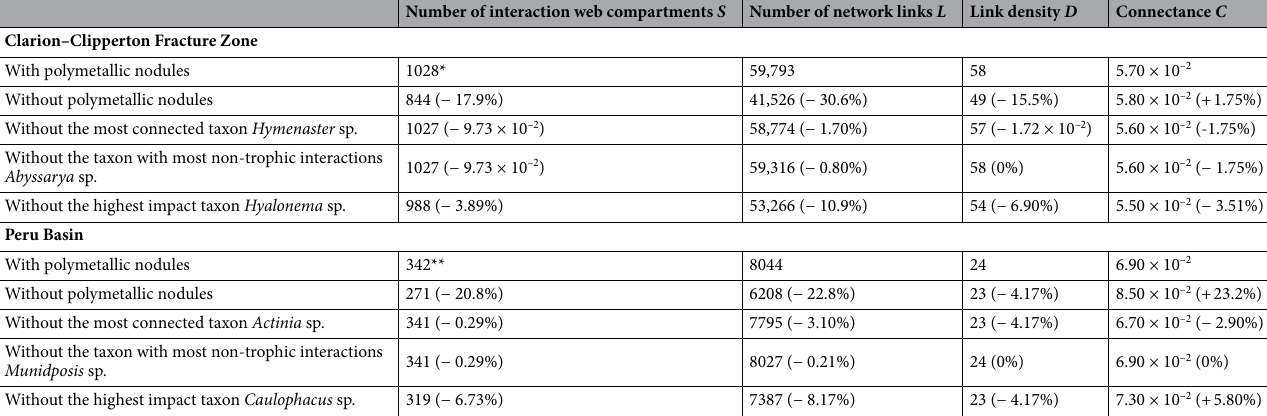
Table 1. Changes in network properties dependent on the presence of, or after the removal of, polymetallic nodules. The network properties were calculated for the trophic interaction webs of the Clarion– Clipperton Fracture Zone and the Peru Basin when polymetallic nodules were present and removed, and without the most connected taxon, without the taxon with most non-trophic links, and without the highest impact taxon. The change in percent with respect to the default web is shown in brackets. *1028 interaction web compartments = 1018 faunal compartments + 9 food source compartments + 1